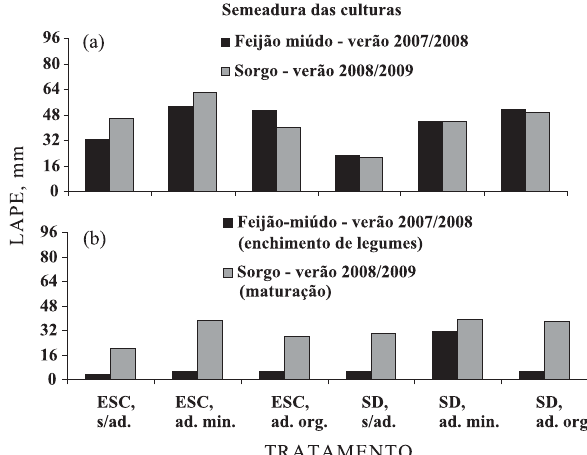
Figura 2. Altura da lâmina de água da chuva infiltrada e retida na superfície do solo no período de pré-enxurrada (LAPE), nos testes de erosão realizados logo após a semeadura das culturas (a) e no estádio fenológico de enchimento de legumes do feijão-miúdo e no de maturação do sorgo (b), nos tratamentos